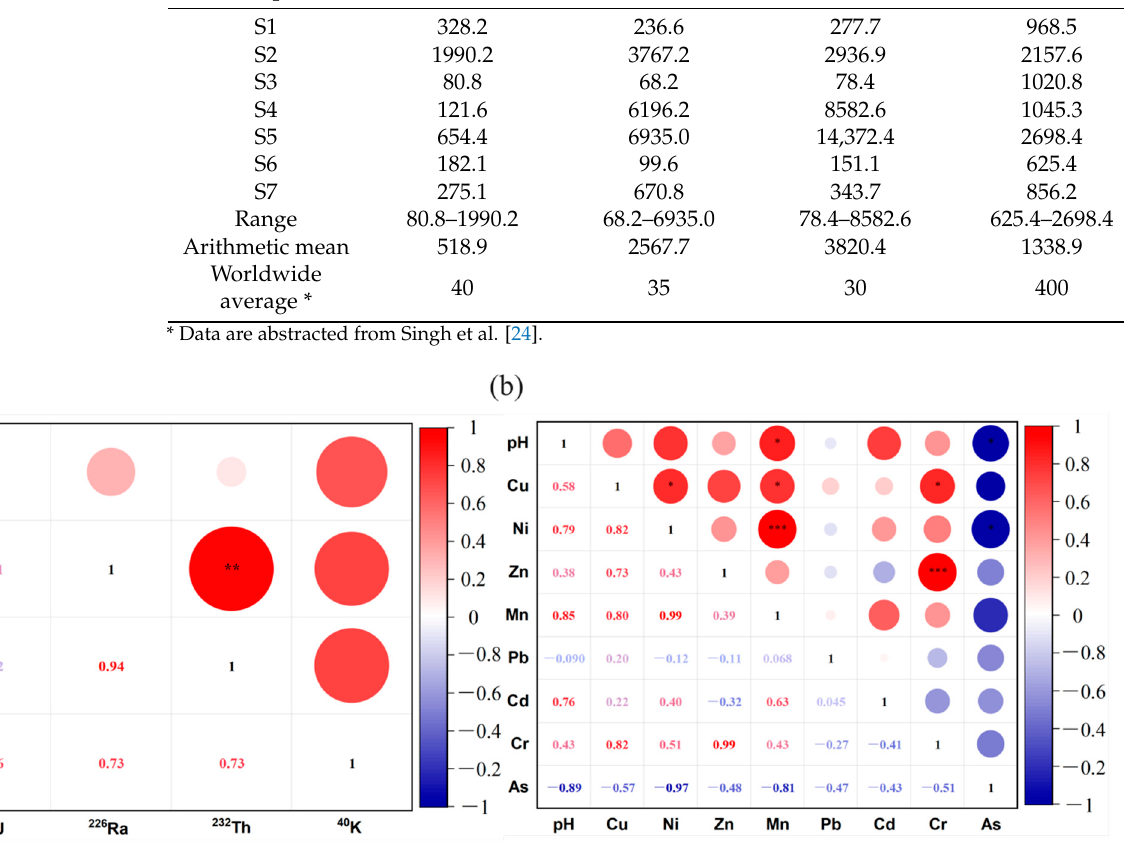
Figure 2. ( a ) Correlation analysis between 238 U, 226 Ra, 232 Th, and 40 K. ( b ) Correlation analysis between pH and 8 PTMs. Significance level: * p < 0.05, ** p < 0.01, *** p < 0.001. between pH and 8 PTMs. Significance level: * p < 0.05, ** p < 0.01, *** p <